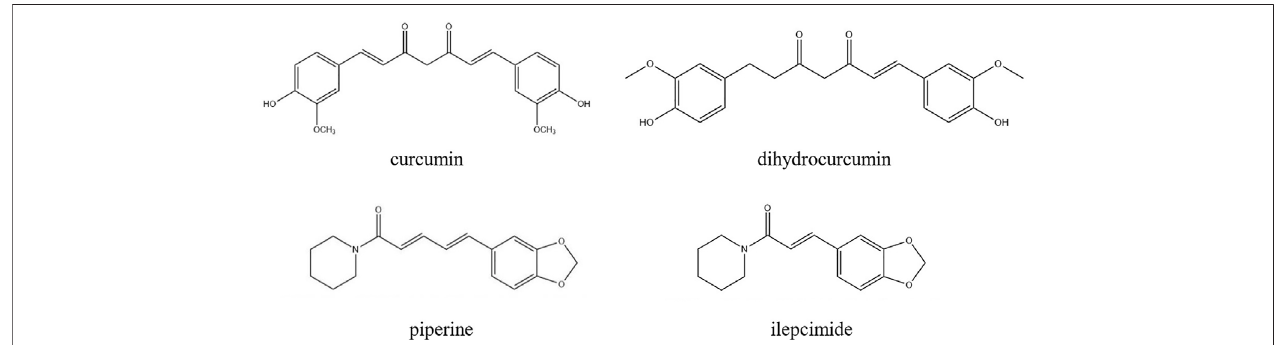
FIGURE 1 | Chemical construction of CUR, DHC, PIP and